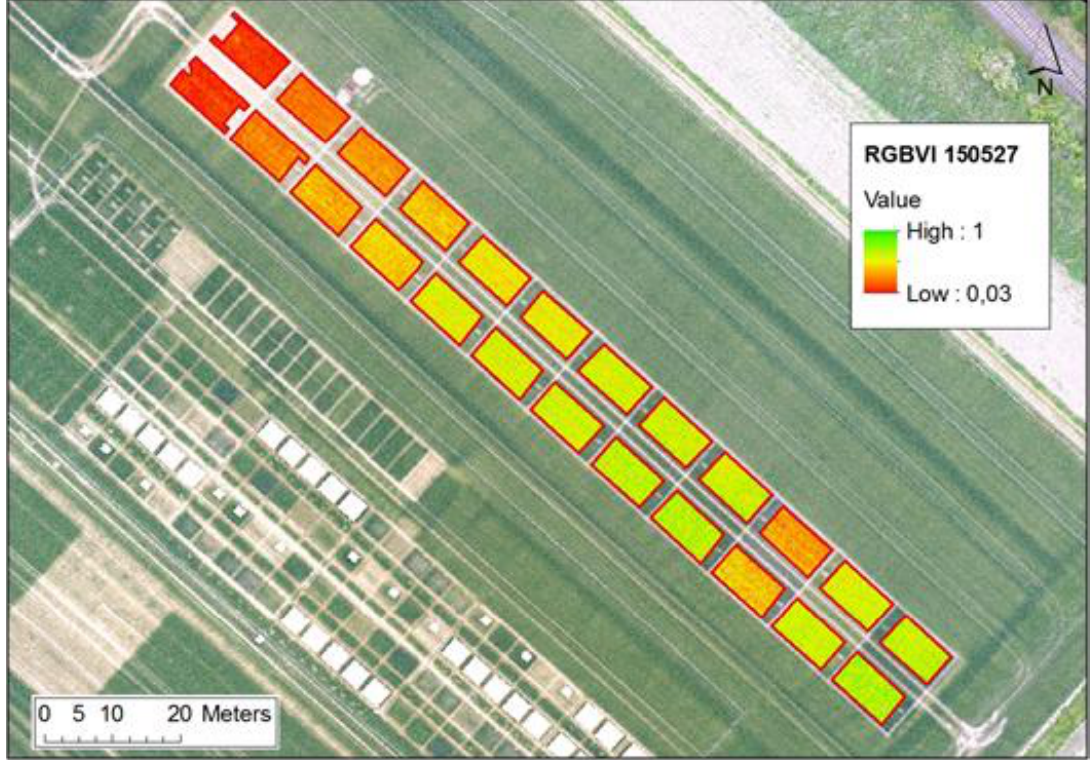
Figure 3. UAV-derived RGBVI data for the N experiment nearby the Research Center Hanninghof When calculated for each of the three phenological stages separately, this correlation is even higher (R 2 of 0.89, 0.92, and 0.99). The results are presented in Fig.4, Fig.5, and Fig.6. The slope of the trendline is different for every date and is decreasing to the later growth stage. Also recognizable is the saturation of the NDVI-like VI in later growth stages which is well described by Li (2008).